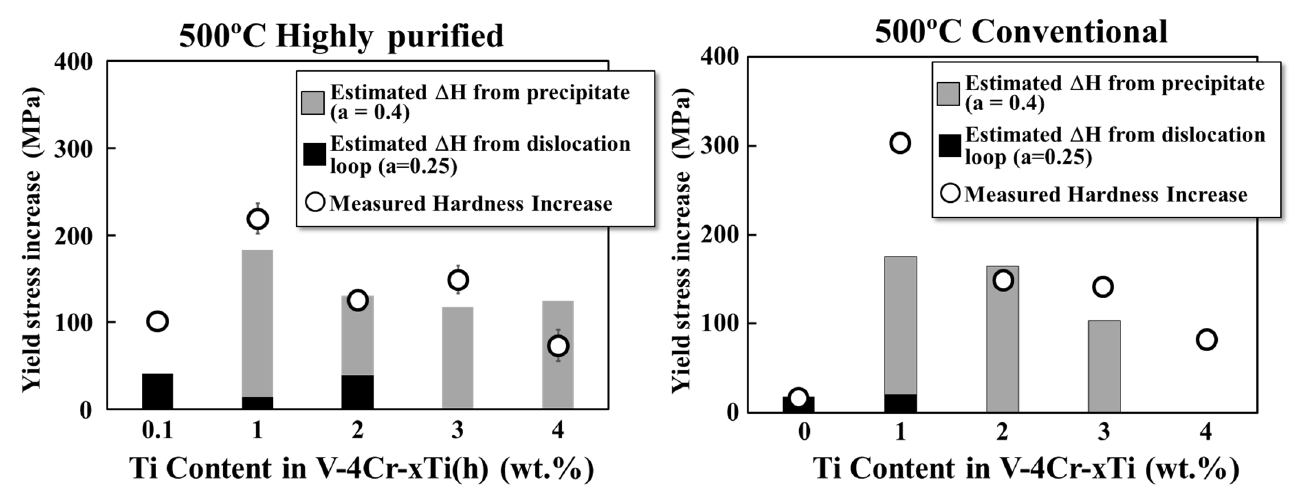
Figure 8. Balance of increase in estimated yield stress in V–Cr–Ti alloy after He-ion irradiation. Open symbols show the yield stress increase estimated through measured nano-indentation hardness. Bar charts show the yield stress increase estimated through the dispersed barrier-hardening model from microstructural information obtained from TEM observation. A gray and black bar chart shows the hardening contribution of Ti(CON) precipitates and dislocation loops, respec- tively.